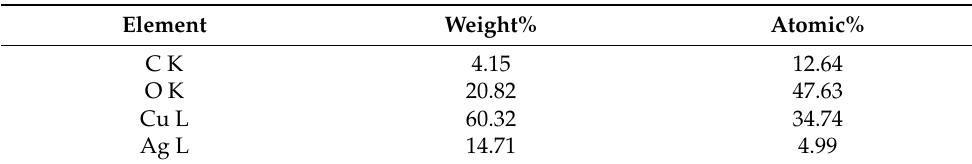
Figure 3. SEM image of ( a ) pure CuO nanosheets, ( b ) rGO@CuO and ( c ) Ag-rGO@CuO. EDX of Ag-rGO@CuO nanocomposite ( d ). Table 1. EDX analysis of ternary Ag-rGO@CuO nanocomposite.